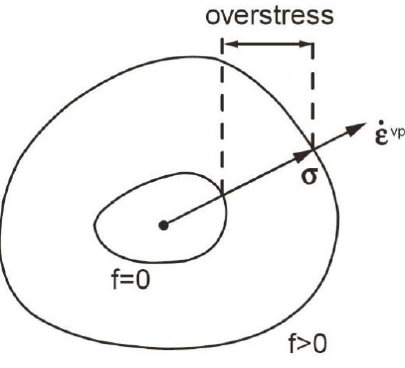
Figure 14: Overstress